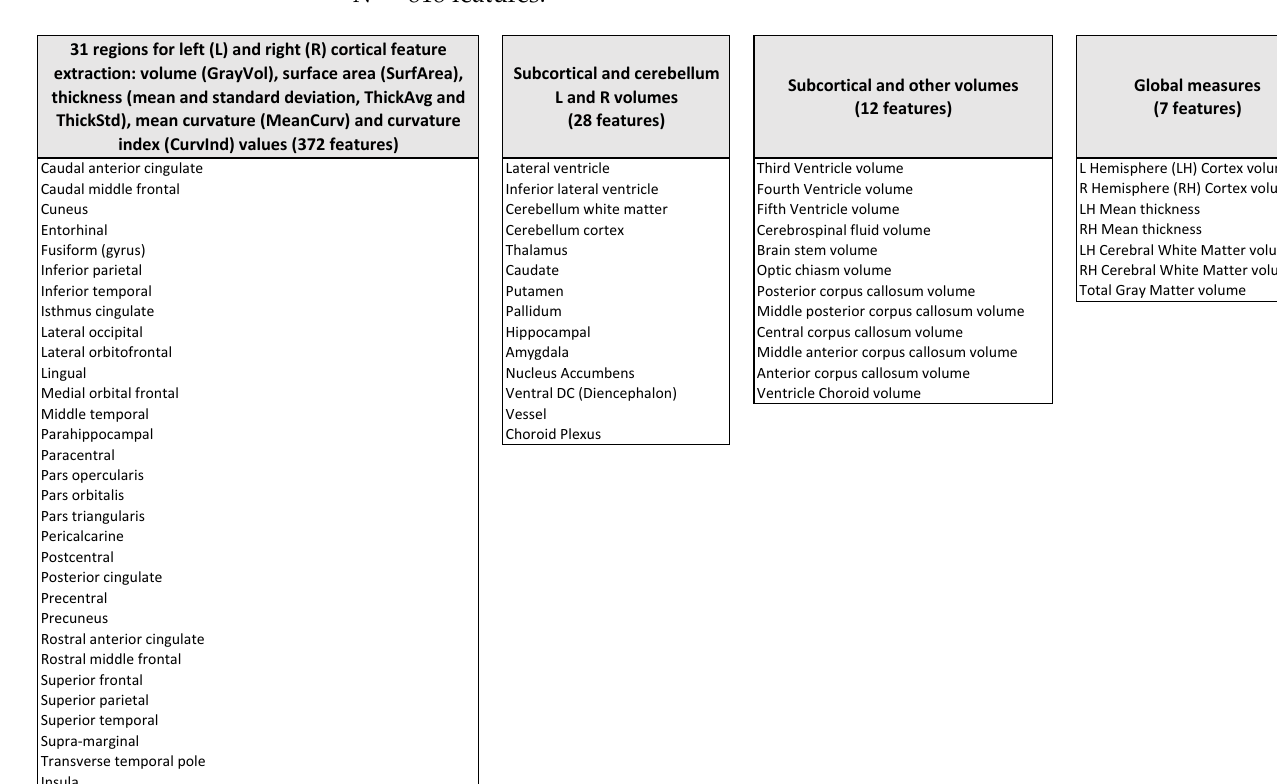
Figure 1. Scheme of the brain features extracted from the ABIDE-I sMRI